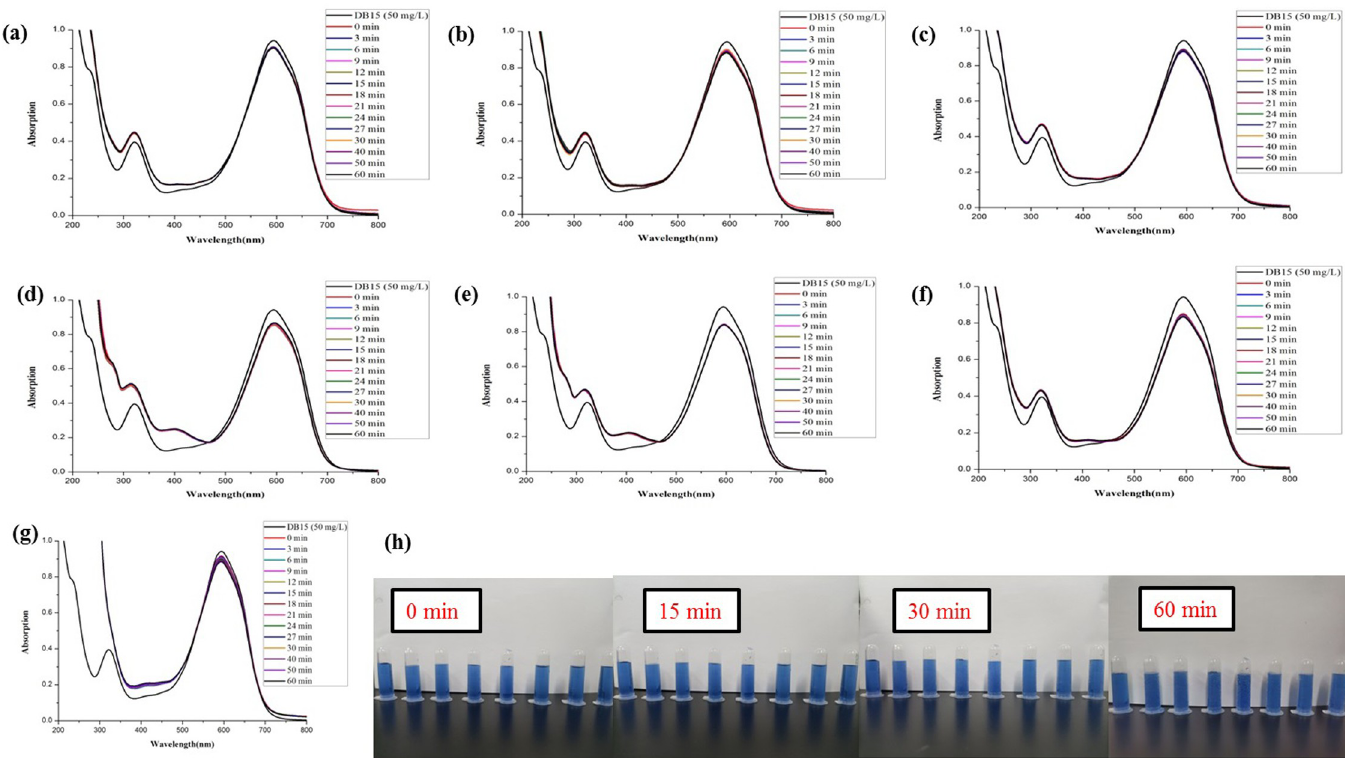
Fig 7. Comparison of the reductive degradation of Direct Blue 15 using different fresh ginger extracts: (a) unpeeled fresh ginger water extract; (b) peeled fresh ginger water extract; (c) fresh ginger peel water extract; (d) unpeeled fresh ginger ethanol extract; (e) peeled fresh ginger ethanol extract; (f) fresh ginger peel ethanol extract; (g) CK; (h) The solution appearance comparison of mixtures different fresh ginger extract and DB15 after reaction for 0, 15, 30 and 60 min. The solutions from left to right are DB15 (50 mg/L), CK, unpeeled fresh ginger water extract, peeled fresh ginger water extract, fresh ginger peel water extract, unpeeled fresh ginger ethanol extract, peeled fresh ginger ethanol extract, and fresh ginger peel ethanol